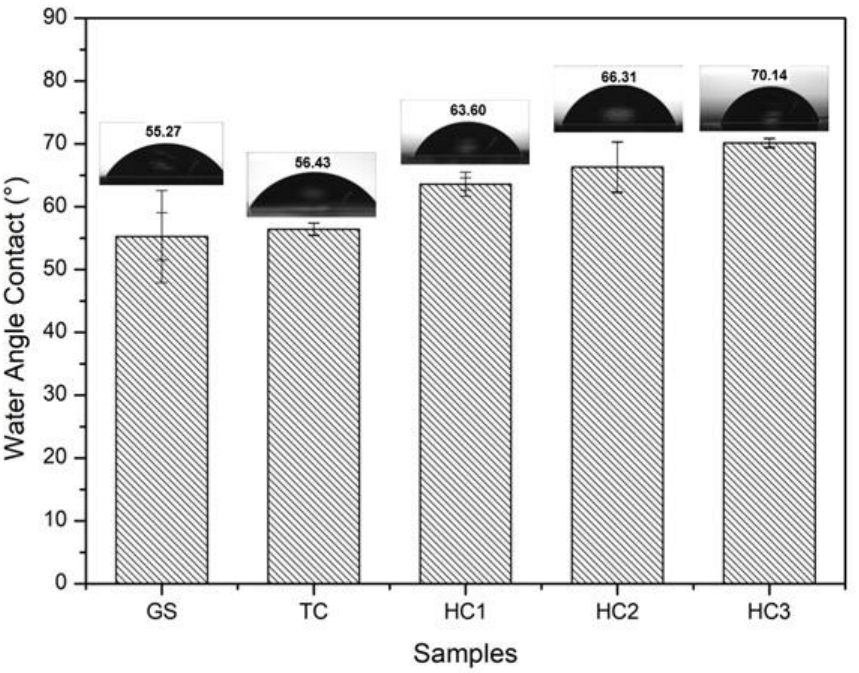
Figure 9. Contact angles of 55.3°, 56.4°, 63.6°, 66.3°, and 70.2° for glass substrate (GS), TC, HC1, HC2, and HC3, respectively.